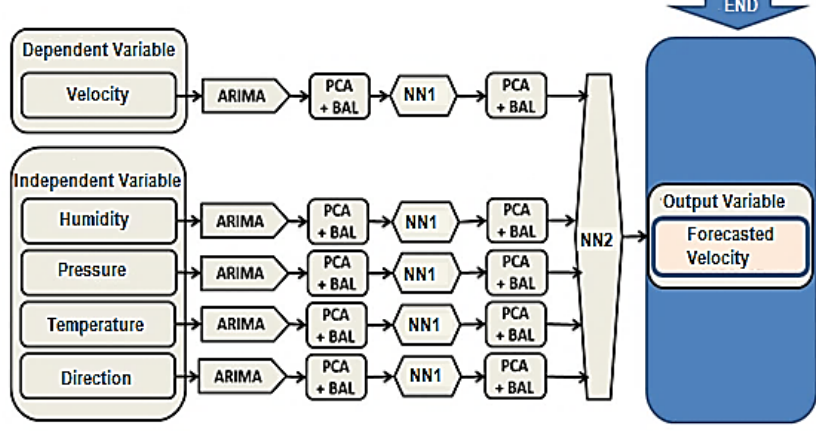
Figure 5. Block diagram of the final step of the model—ARIMA + NN1 + NN2.